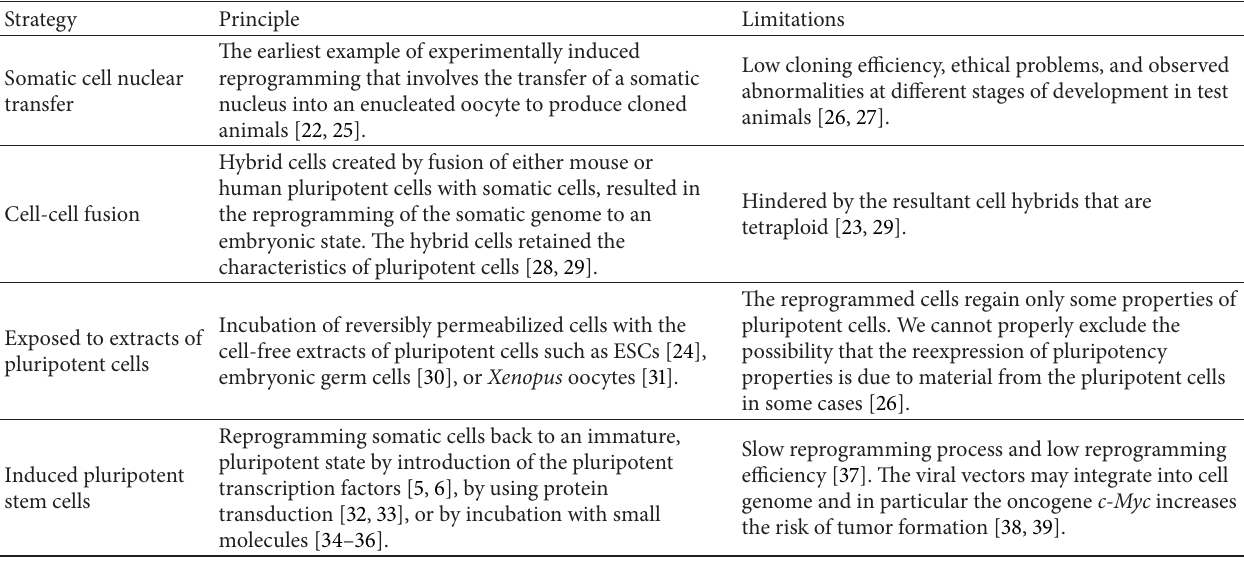
Table 1: Approaches for establishing stem